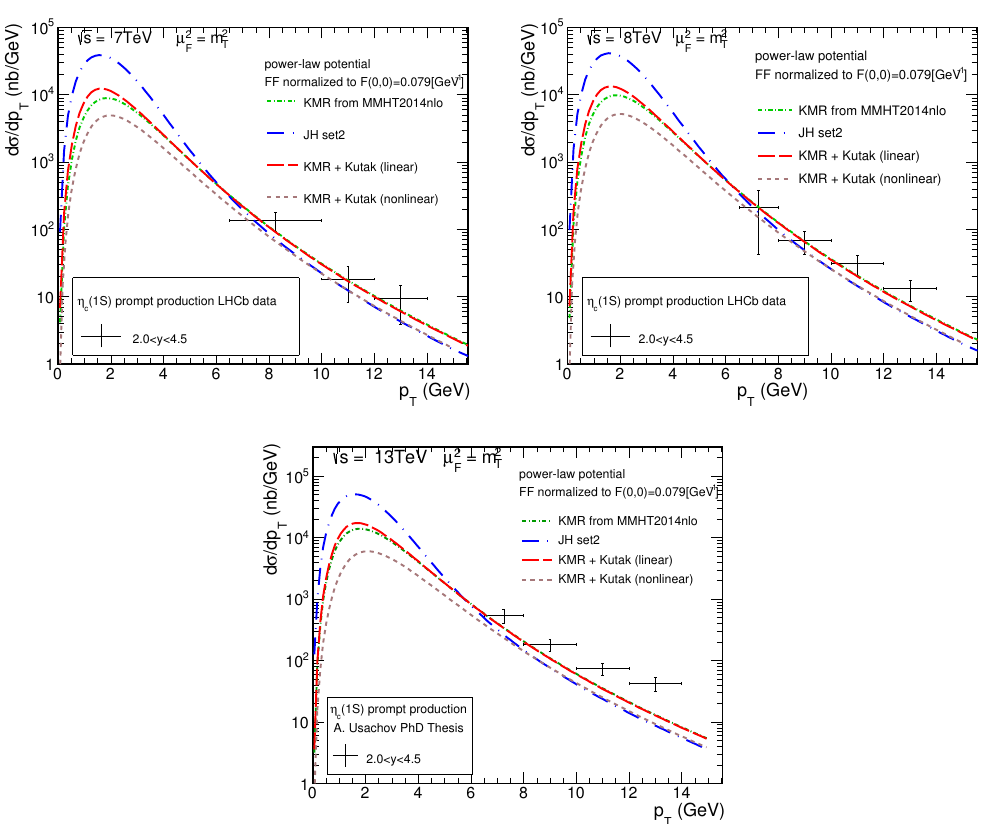
Figure 5 . Di(cid:11)erential cross section as a function of transverse momentum for prompt (cid:17) c (1 S ) p production compared with the LHCb data [13] for s = 7 ; 8 TeV and preliminary experimental p data [14] for s = 13 TeV. Di(cid:11)erent UGDs were used. Here we used the g (cid:3) g (cid:3) ! (cid:17) c (1 S ) form factor calculated from the power-law